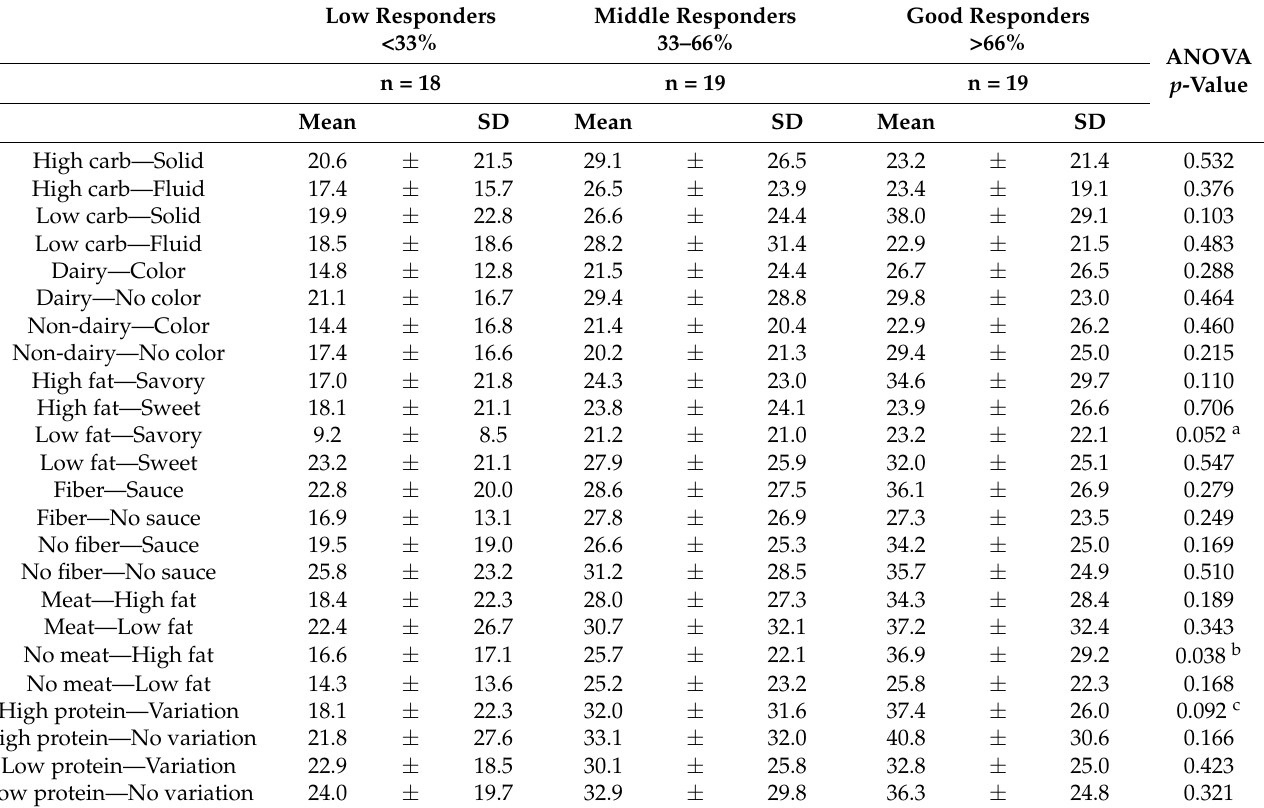
Table 4. Relationship between explicit wanting for foods regarding percentage of total weight loss